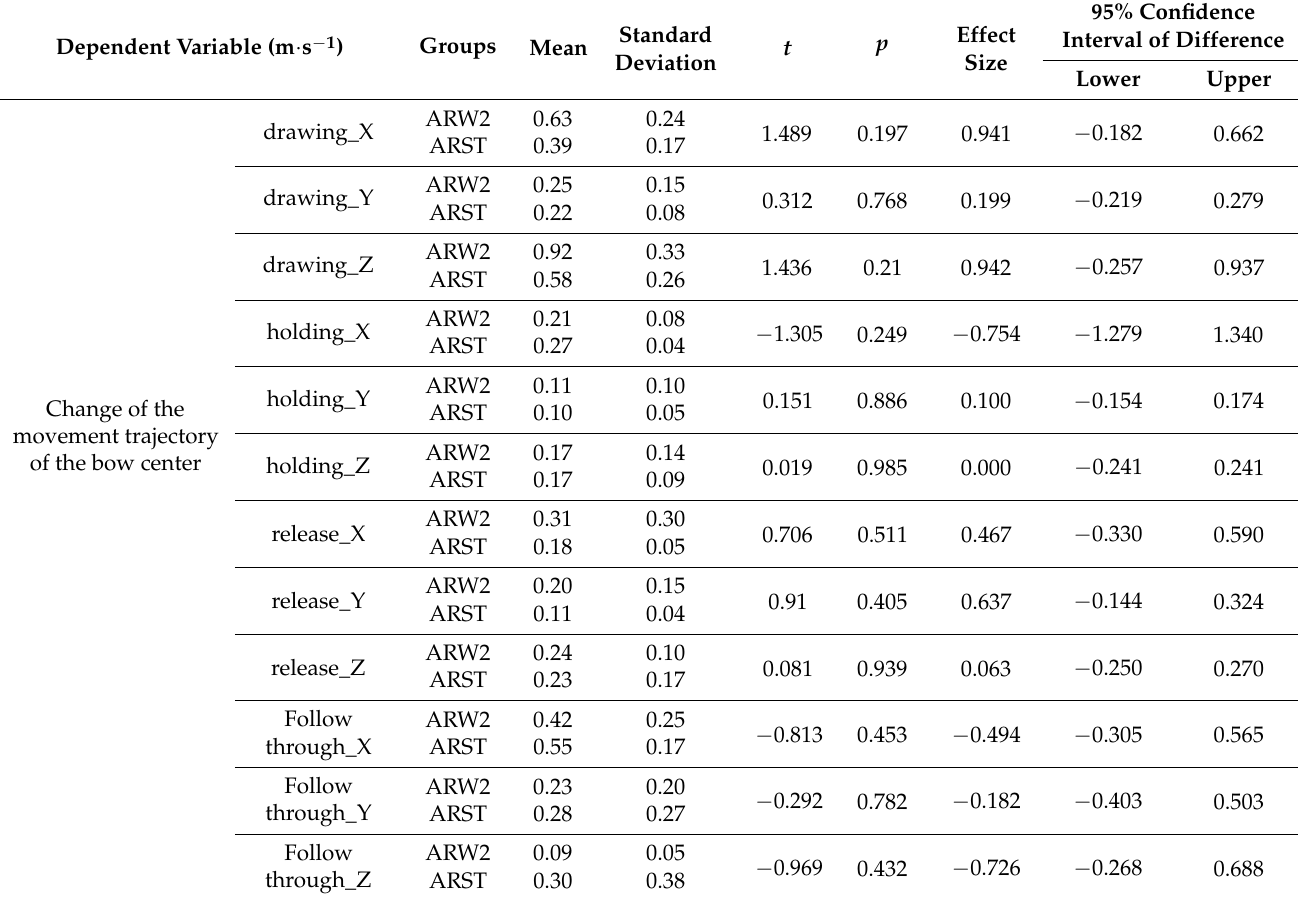
Table 6. Change of the movement trajectory of the bow center by